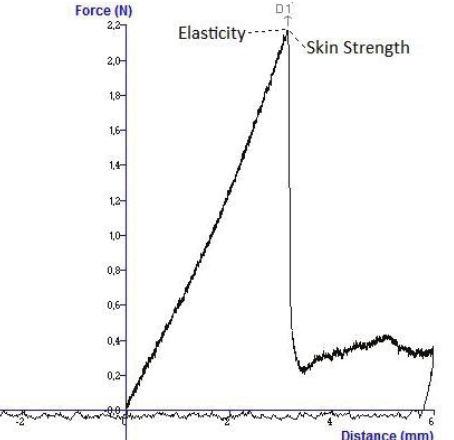
Figure 2: Texture profile analysis for physalis